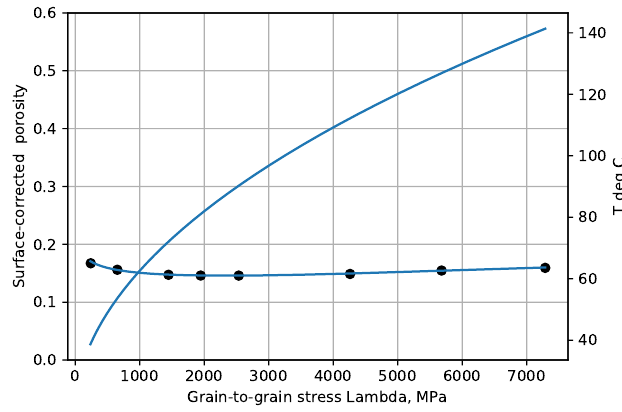
Figure 17. Oklahoma.